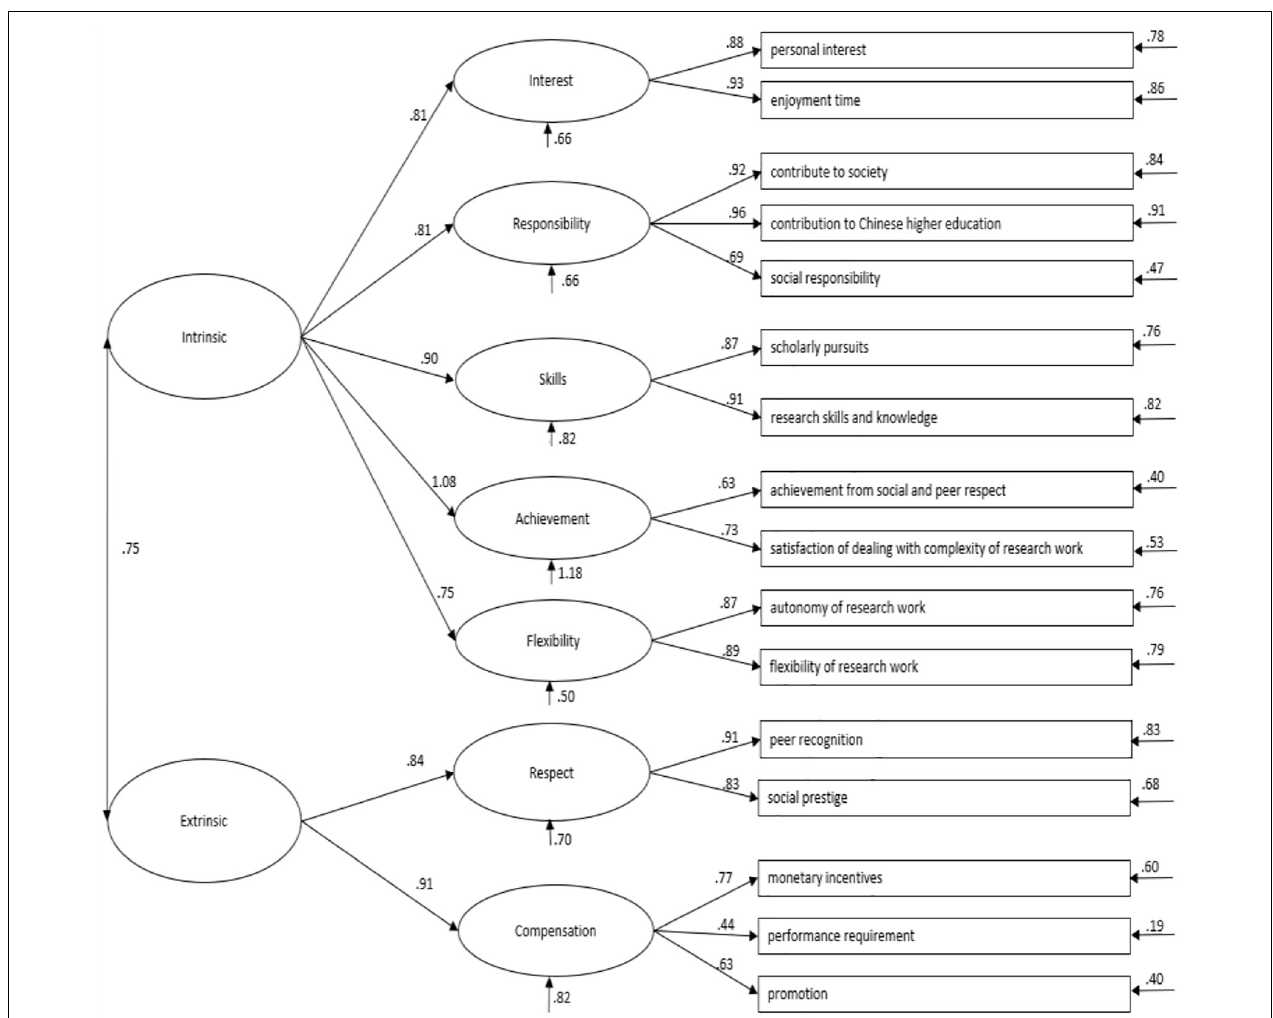
FIGURE 4 | The structure of the seven-factor correlate research motivation model. IN, interest; RE, responsibility; SK, skills; AC, achievement; FL, flexibility; RES, respect; COM,